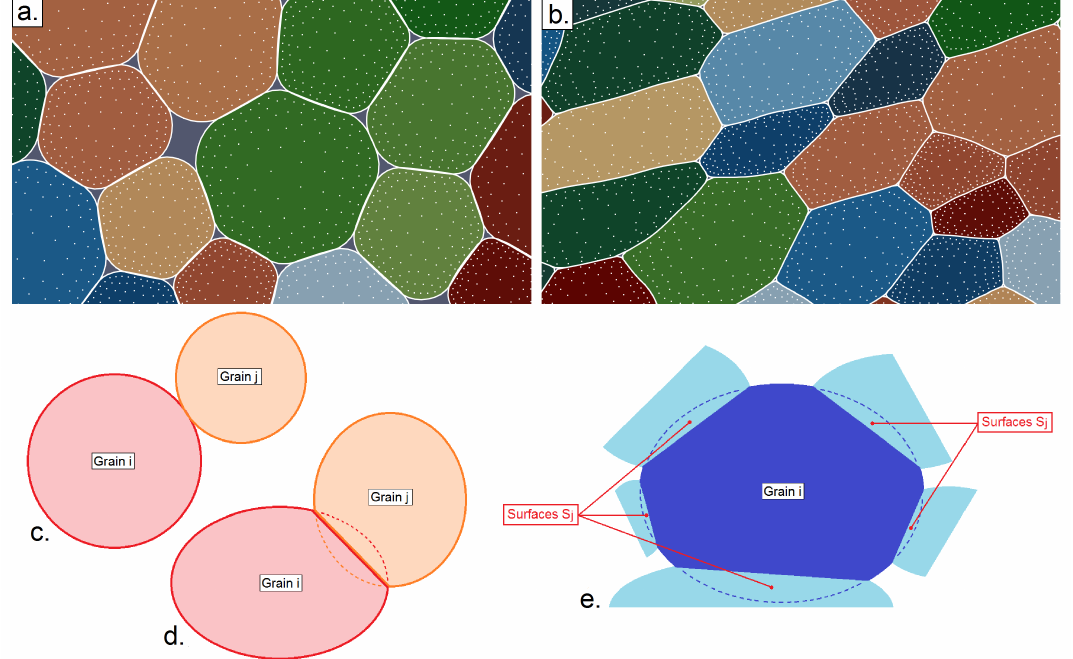
Figure 5: Towards a less costly way to simulate soft grains [64]. a : Snapshot of a Multibody Meshfree simulation of soft grains under isotropic compression, showing the contact flattening and the pore space closure; b : A similar simulation but with a deviatoric loading, showing the general ovalisation of the grains; c : The classical DEM point contact between discs with a sufficiently large contact stiffness; d : The SDEM segment-contact between ellipses with a large local deformation; e : Correction of the surface deficit associated with the large interpenetration through an additional term on the volumetric strain of the